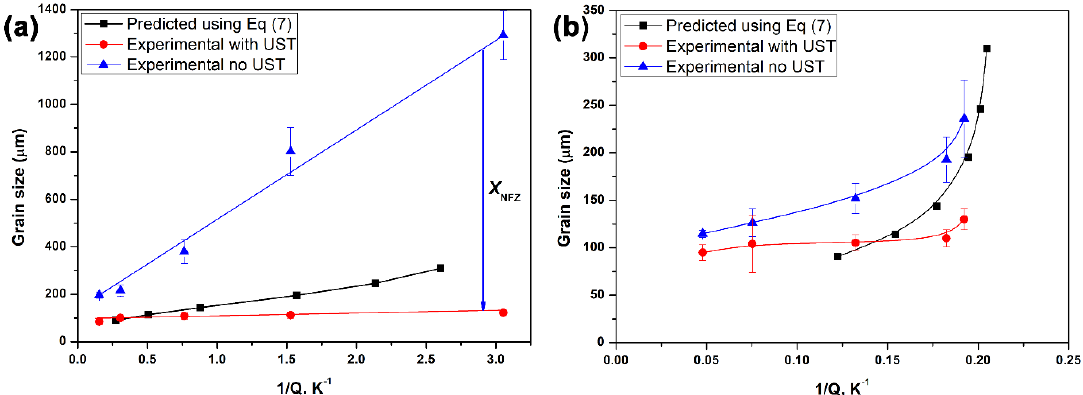
Figure 19. Prediction of grain size using Equation (4) for ( a ) Al-Ti and ( b ) Al-2Cu-Ti alloys with and without UST [46].